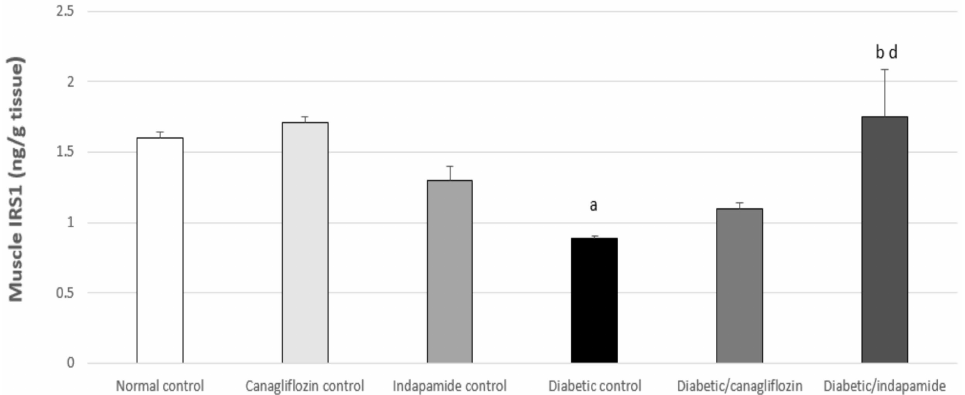
Figure 11. Impact of daily CANA and INDA treatment on soleus muscle IRS1 expression: oral CANA and INDA treatments were initiated once daily for 4 weeks. Data represent the mean ± S.E.M. (6 rats/group). ANOVA followed by post hoc Tukey–Kramer test at ( p < 0.05) was used for statistical comparison; a against normal CTRL, b against diabetic CTRL, d against